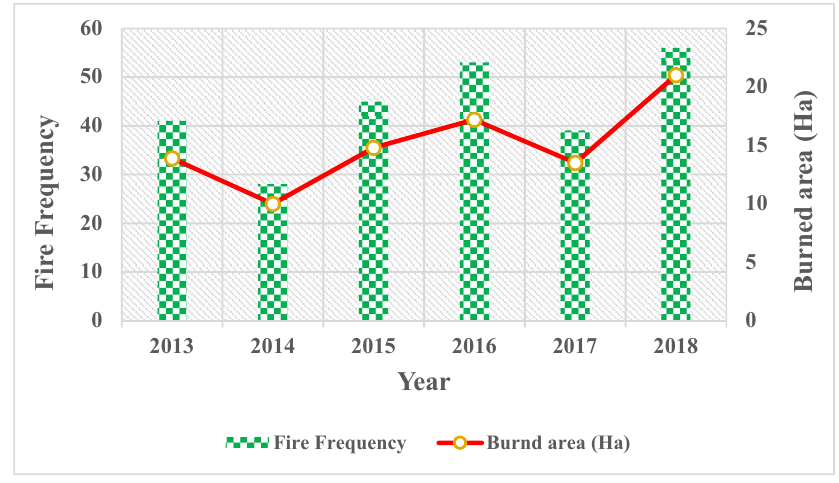
Figure 4. Result of the fire frequency.